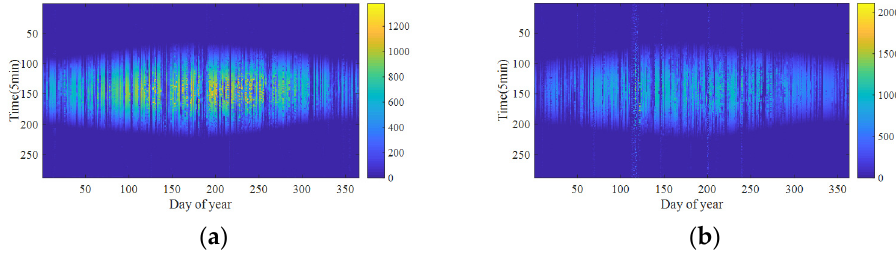
Figure 2. Visualization of the global horizontal irradiation. ( a ) 2018; ( b ) 2019.